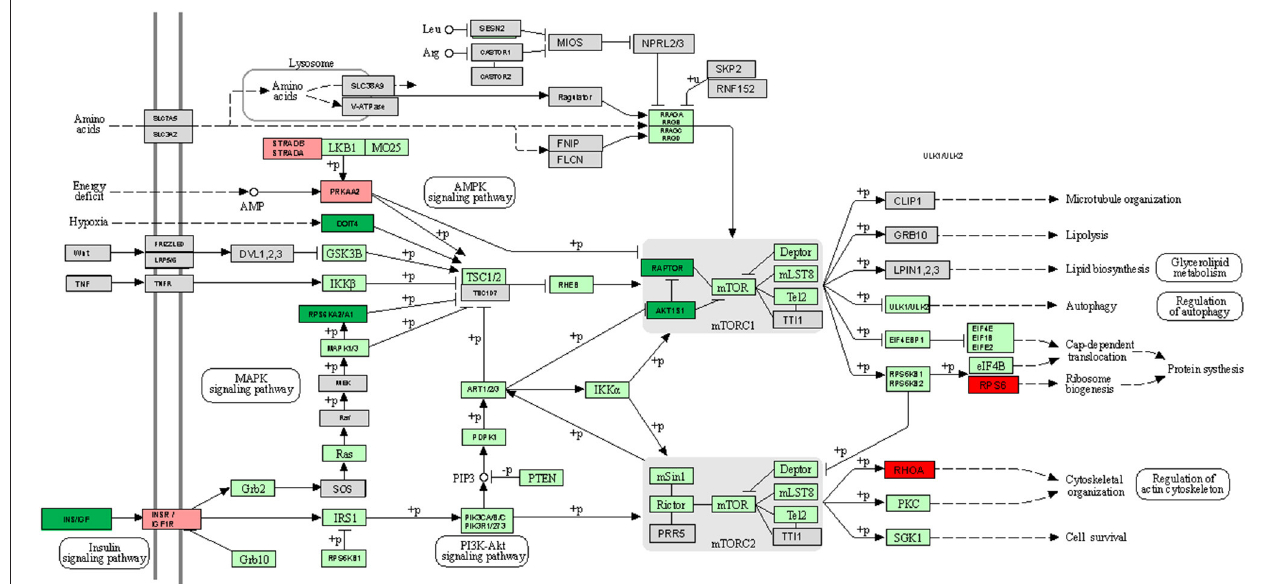
TABLE 4 | Classification of mTOR complex as a function of differential expression between patients with rejection ( + DSA/ + AMR) and without rejection ( + DSA/–AMR and –DSA/–AMR). mTOR complexes Up-regulated Moderately up-regulated Down- mTORC1 Complex RPTOR MLST8, MTOR